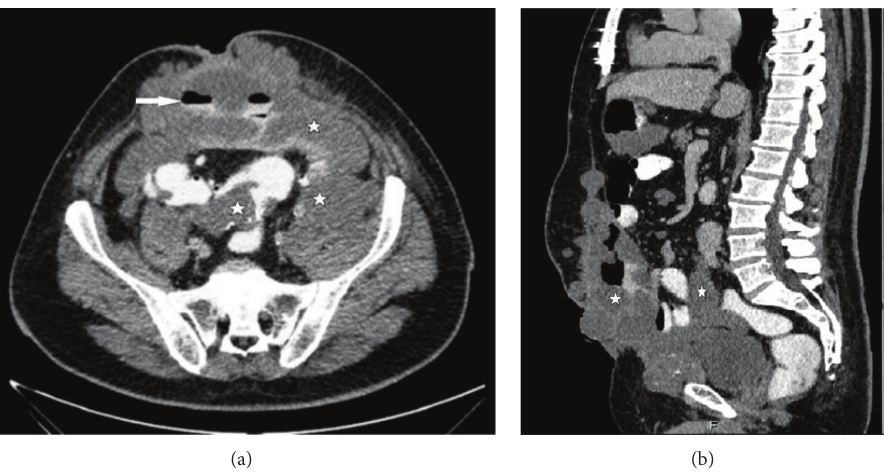
Figure 2: Cross-section (a) and sagittal (b) multiplanar reconstruction from CECT. These images demonstrate that the tumor creates air-fluid levels (arrow) by wrapping segments of intestine (stars) and extends from the anterior of the bladder to the anterior wall of the abdomen.